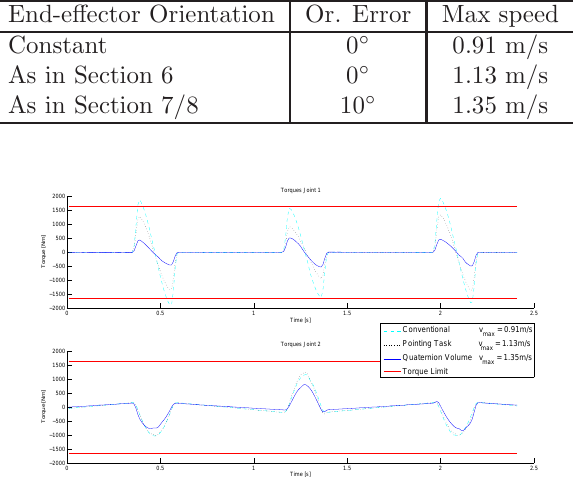
Figure 5: The torques of joints 1 and 2 for the given